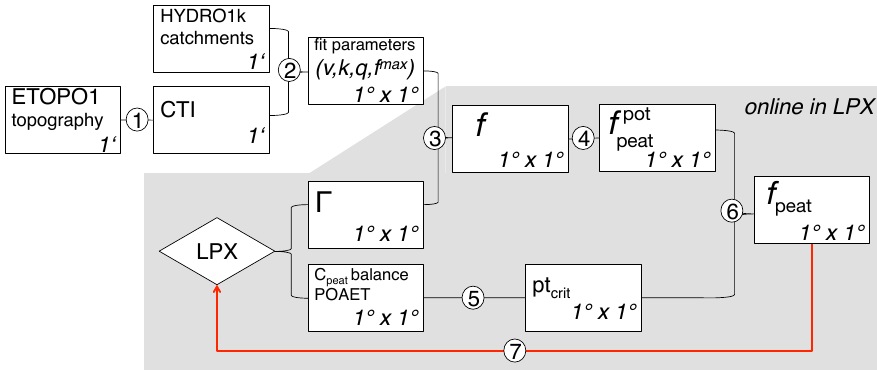
Figure 1. Overview of information flow of DYPTOP. Boxes represent spatial fields of the respective variables, given at the spatial resolution as indicated in the lower right edge of each box. (1) Compound topographic index (CTI) values are derived from the ETOPO1 (2013) high resolution topography data set using the R library “topmodel” (Buytaert, 2011). (2) Fit parameters (v,k,q) are derived by applying the least- squares fitting algorithm “nls” in R (R Core Team, 2012) to best reproduce the “empirical” relationship between the water table position ( (cid:48) ) and the flooded area fraction ( f ) as derived from the ETOPO1 data and Eqs. (2) and (3). f max is the maximum area fraction that is allowed to be flooded within a grid cell and is computed by using a globally uniform threshold value for CTI (CTI min ) below which flooding is prohibited (Eq. 4). (3) (v,k,q,f max ) are prescribed to LPX-Bern to predict f as a function of (cid:48) , which is interactively simulated